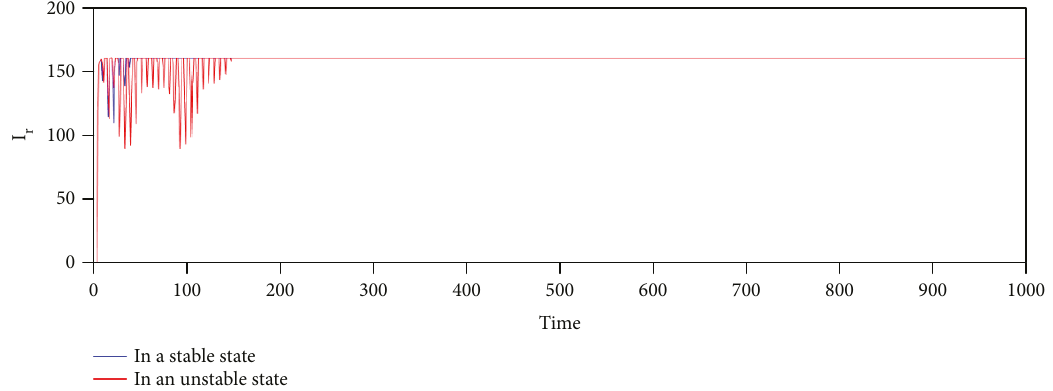
Figure 13: Comparison of retailers ’ opening stock changes in a stable state and unstable state under fi xed constant